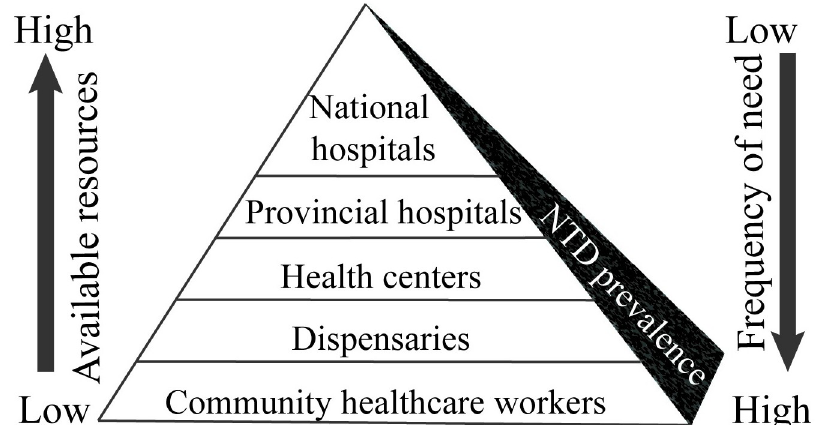
Fig 5. The healthcare paradox for NTDs in endemic regions. At the lowest level, the healthcare system in the NTD endemic region has minimally trained CHWs capable of providing referrals to a level up such as local dispensaries with limited resources including technicians and/or midwives, followed by health centers with trained medical professionals, laboratory space, equipment, and/or inpatient wards. These CHWs at the base of the pyramid also play a vital role in facilitating mobile health outreach services, thereby bridging the gap between patients and medical facilities. One level further up is adequately equipped provisional hospitals followed by fully functional national hospitals at the top of the pyramid. Notably, the burden of NTDs is highest at the lowest healthcare level. This indicates the healthcare paradox, i.e., the highest NTD needs occur at the base of the pyramid where resources are inadequate, and, thus, the disease spreads further due to unmet healthcare needs. To interrupt this vicious cycle of disease endemicity, easy-to-use NTD diagnostics should be introduced to the CHWs at the lowest level. Bringing NTD diagnostics at the doorstep of the endemic populations will ensure efficient disease diagnosis and treatment, reduce costs, and thereby alleviate the healthcare burden. CHW, community healthcare worker; NTD, neglected tropical